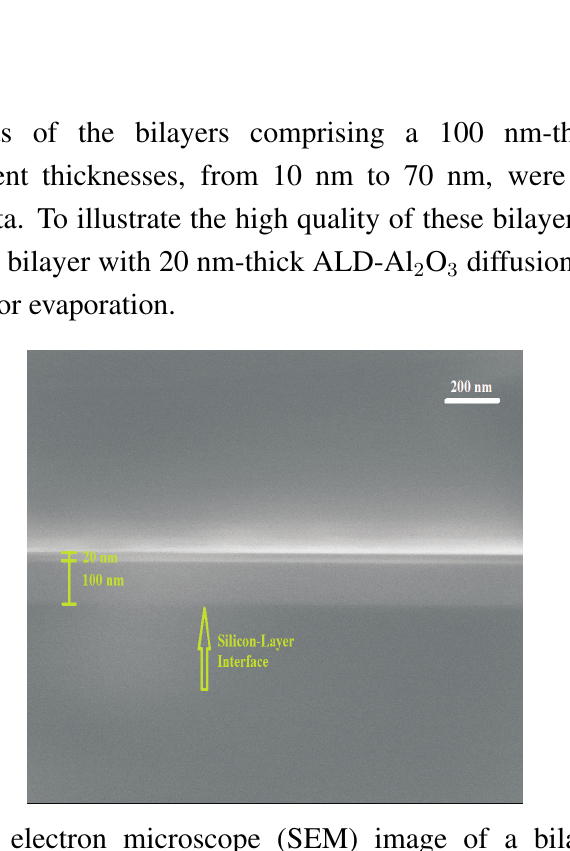
O film, on a Si 2 3